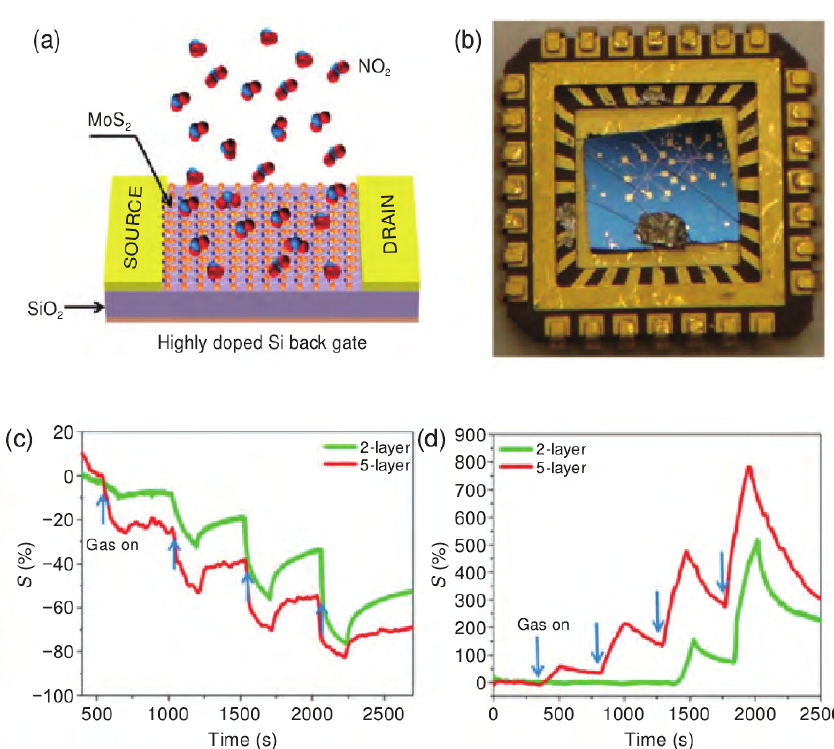
Figure 6. Sensing behavior of atomically thin-layered MoS 2 transistors. ( a ) Schematic of the MoS 2 transistor-based NO 2 gas-sensing device. ( b ) Optical photograph of the MoS 2 sensing device mounted on the chip. Comparative two- and five-layer MoS 2 cyclic sensing performances with NH 3 . ( c ) and NO 2 (for 100, 200, 500, 1000 ppm) ( d ). Reprinted with permission from Ref. [78]. Copyright 2013